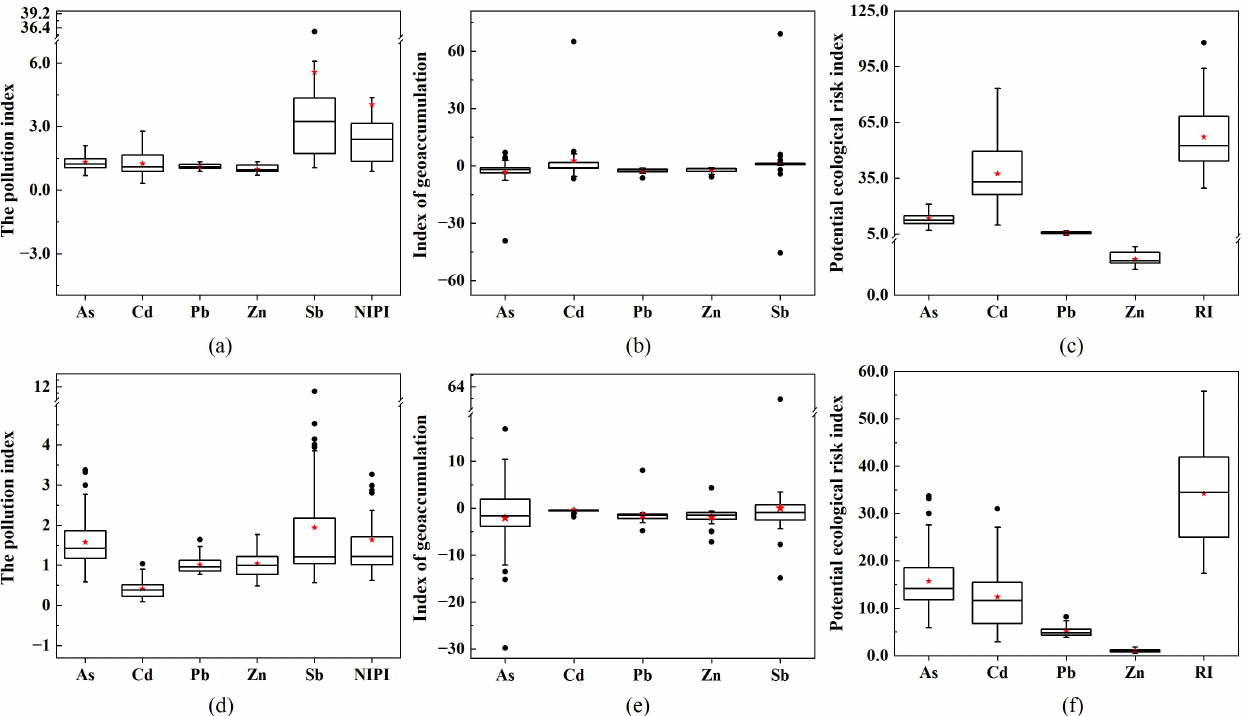
Figure 11. Geological accumulation index, potential ecological risk index, and the single factor index of heavy metals and metalloids for topsoil ( a – c ) and profile soil ( d – f ). (The circles at the top and bottom of the box plot correspond to the maximum and minimum values, respectively. The pentagrams in the box plot are the mean values. The horizontal lines at the top, middle, and bottom of the box plot represent the 75th percentile, median, and 25th percentile,